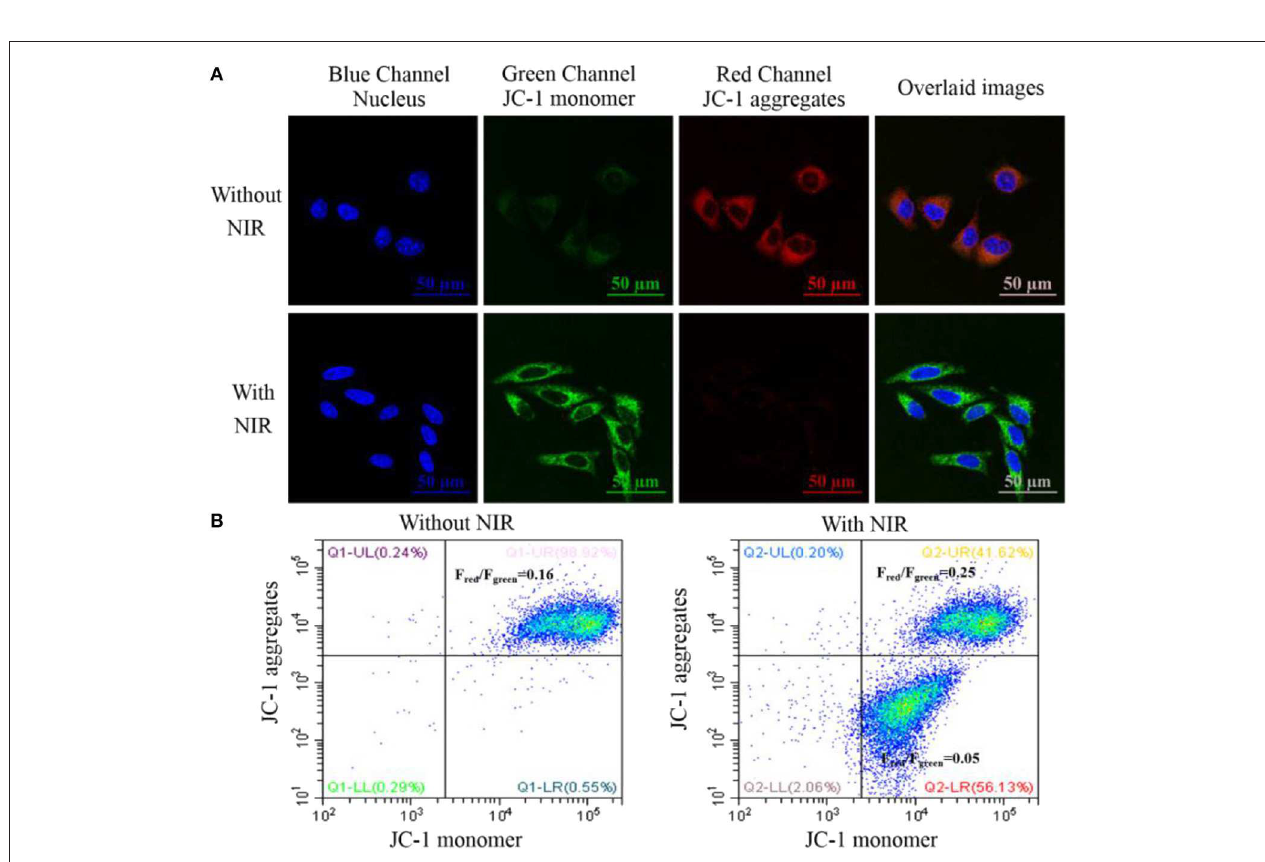
FIGURE 7 | (A) CLSM images of intracellular mitochondrial membrane potential stained with the JC-1 dye. MCF-7 cancer cells were incubated with 70 µ g/mL of the prepared nanotheranostic agent for 12h. The nucleus information was recorded at the blue channel from 420 to 480nm under the excitation of 405nm. The fluorescence signal of the monomeric JC-1 dye was recorded at the green channel from 500 to 550nm under the excitation of 488nm; the fluorescence signal of the aggregated JC-1 dye was recorded at the red channel from 580 to 640nm under the excitation of 561nm; overlaid images of the three channels; (B) flow cytometry to evaluate the 19 m change of MCF-7 cancer cells using JC-1